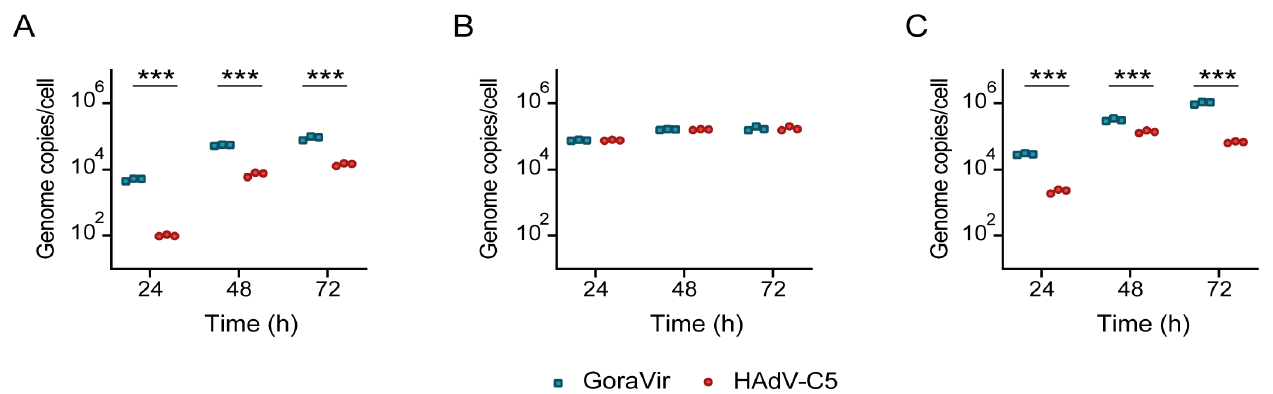
Figure 3. Replication kinetics of GoraVir and HAdV-C5 in pancreatic cancer cell lines. ( A ) BxPC-3, ( B ) HPAF-II, and ( C ) MIA PaCa-2 cells were infected with either GoraVir or HAdV-C5 at MOI 2 and viral genome copies were determined at 24, 48, and 72 hpi. Means are depicted of n = 3 biologically independent replicates. Statistical analyses were performed using multiple unpaired t tests and the Holm-Šídák correction. Significant differences are indicated by asterisks, with p values < 0.001 shown as ***.